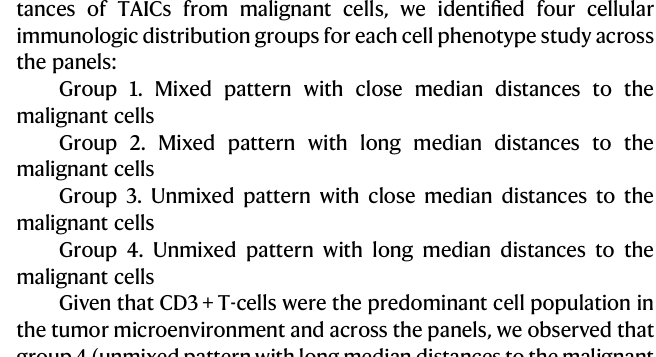
Poissoncurve scoreshows two groupsofinteractionbetweenthemostcriticalcell phenotypesobservedandmalignantcells.Cellphenotypeswithascoreof − 10to10 were characterized as having a mixed/heterogeneous pattern indicating more interaction with malignant cells, and cell phenotypes with a score of >10 were characterized as having an unmixed/clustering pattern indicating less interaction with malignant cells. G Median distance heat map representing the 27 most com- mon tumor-associated immune cells near malignant cells (CK+) across the multi- plex immuno fl uorescence panels in adenocarcinomas (ADCs=142 samples) and squamous cell carcinomas (SCCs=83), data from 225 samples was used. Experi- ments and quanti fi cations related to the presented results were conducted once. Graphs and heat map were generated using R studio software version 3.6.1. mIF imagesweregeneratedusingVectra-Polaris1.0.13scannersystemandInForm2.4.8 image analysis software (Akoya Biosciences). (Source data is provided as a source data fi